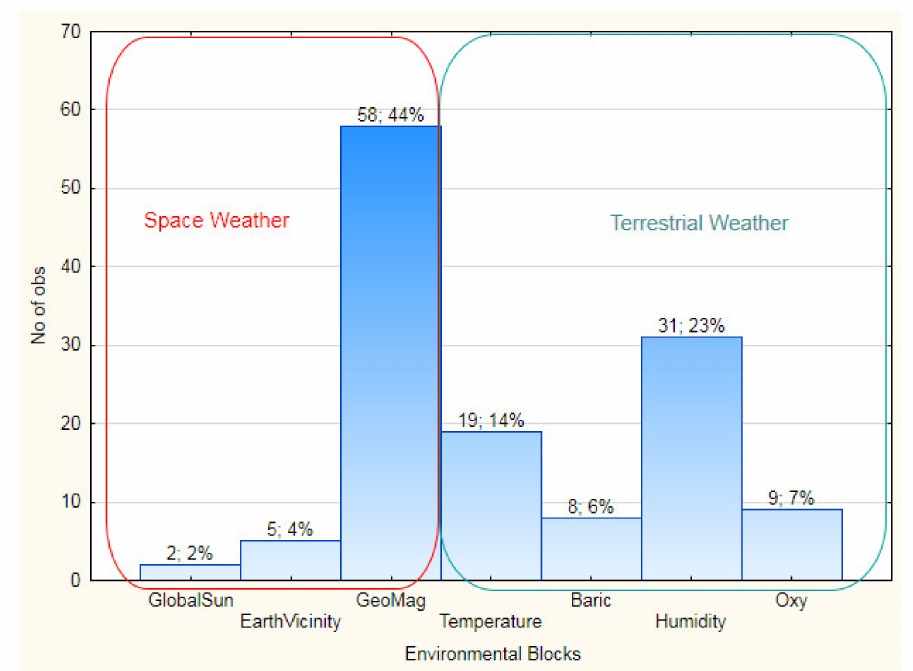
Figure 11. The distribution of the Space Weather and Terrestrial Weather characteristics, which differ when they are correspond to the different medical events, by the environmental blocks. Block names: global solar activity variations (GlobalSun), variations of the solar activity flare component (SolarFlare), variations of the particle fluxes and X-ray fluxes in the Earth’s vicinity (EarthVicinity), variations of the geomagnetic characteristics (GeoMag), variations of pressure systems characteristics (Baric), variations of the humidity characteristics (Humidity), variations of the air temperature characteristics (Temperature) and variations of the air oxygen weight content characteristics (Oxy). Only parameters are those common for both gender